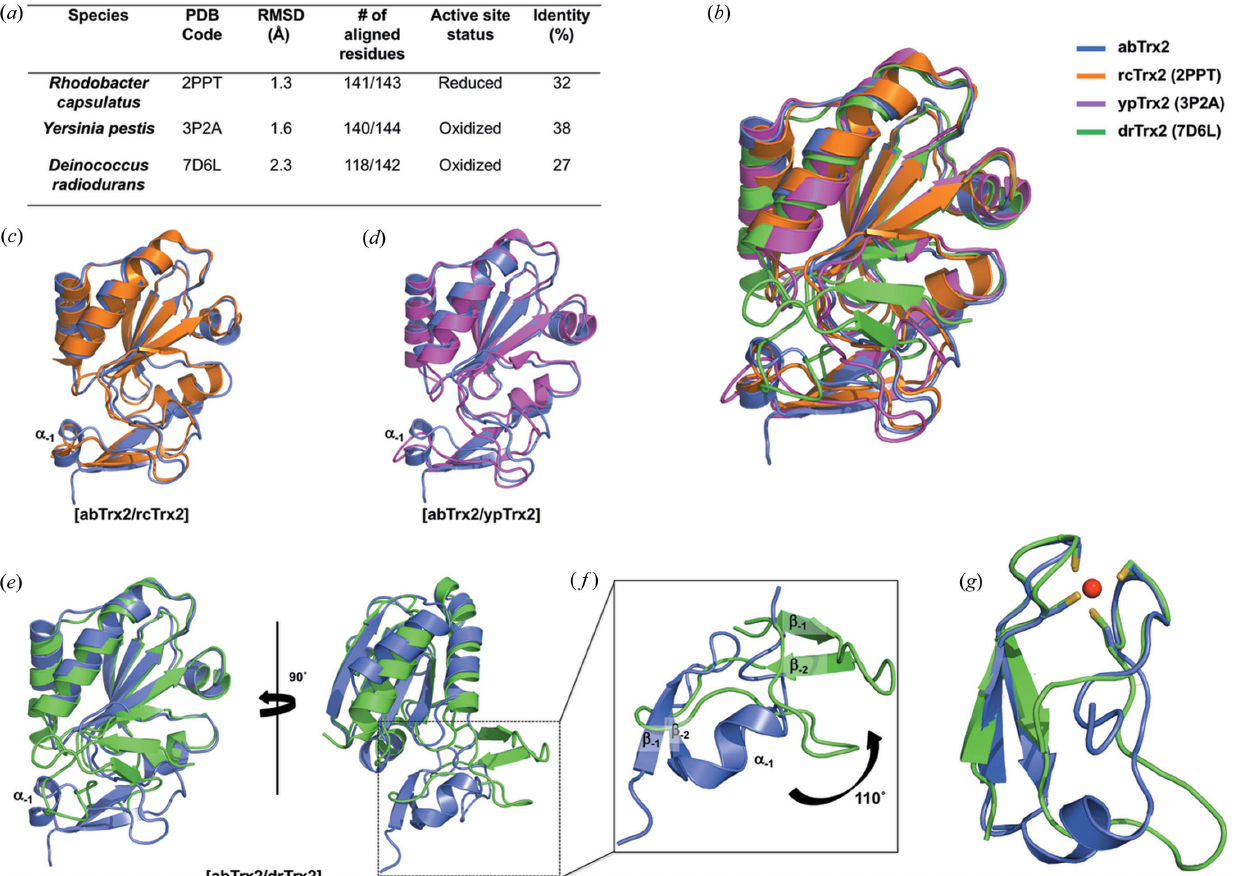
Figure 3 Structural comparison of abTrx2 with isoforms from different species. ( a ) A table summarizing the results of a DALI search. ( b ) Structural superimposition of abTrx2 with the top three structures that were identified as structural homologues by the DALI server (Holm & Sander, 1995) (rc: R. capsulatus ; yp: Y. pestis ; dr: D. radiodurans ). The PDB IDs are provided in the parentheses. ( c ),( d ) Pairwise structural superimposition of abTrx2 (blue) with ( c ) rcTrx2 (orange) and ( d ) ypTrx2 (magenta). ( e ) Pairwise structural comparison of abTrx2 (blue) with drTrx2 (green). ( f ) A magnified view of the zinc-finger domain from the superposed structures of abTrx2 (blue) and drTrx2 (green). ( g ) Structural superposition of the zinc-finger domains of abTrx2 (blue) and drTrx2